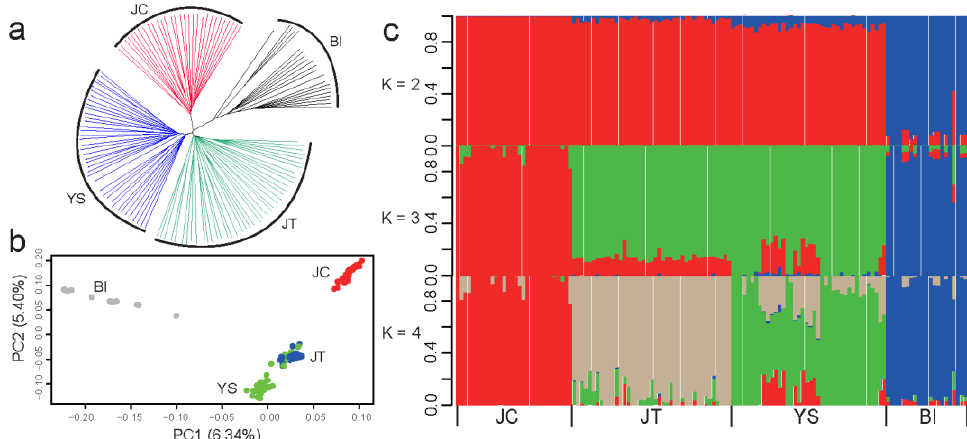
Figure 1. Genetic relationships and population structure of three black Chinese goat breeds and Bezoar ibexes. ( a ) Neighbor-joining (NJ) phylogenetic tree of three black Chinese goat breeds (i.e., Jianchang Black [JC], Jintang Black [JT], and Yunshang Black [YS]) and 21 Bezoars (BI) based on the identical-by-state (IBS) distance. ( b ) Principal component analysis (the first and second principal components [PC1 and PC2]) of 111 domestic goats and 21 Bezoars. ( c ) Proportions of genetic ancestry for 111 domestic goats and 21 Bezoars with K = 2~4 (K represents the number of inferred ancestral populations).